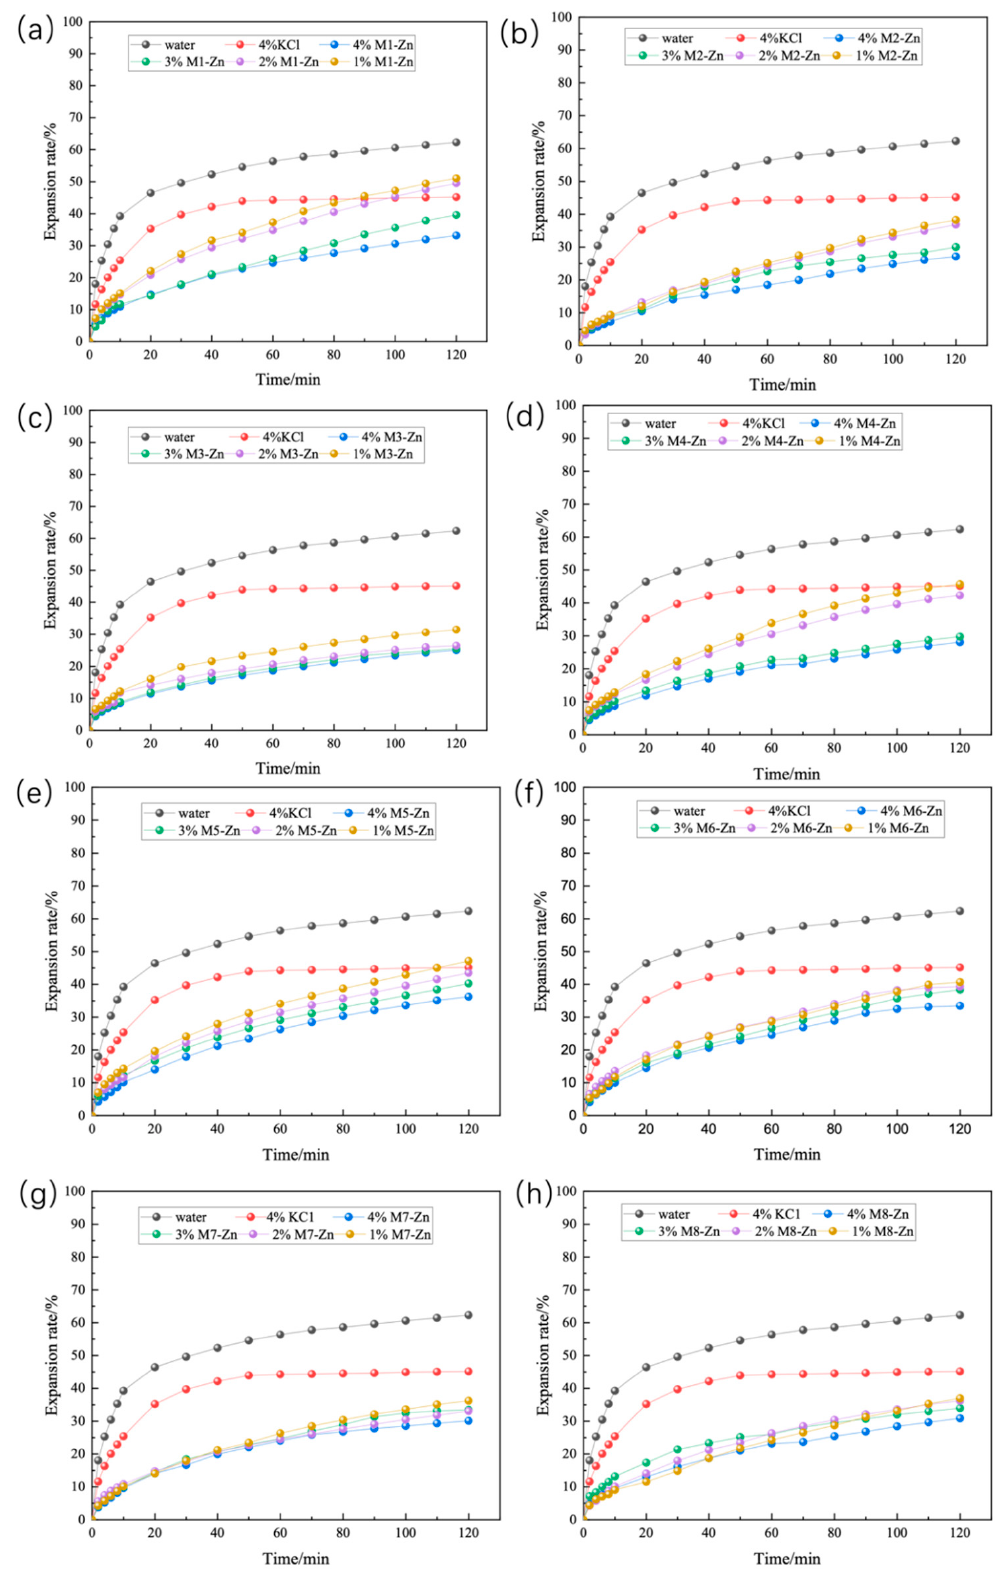
Figure 1. Linear expansion of Zn-doped MMH with different concentrations (( a ): M1-Zn; ( b ): M2-Zn; ( c ): M3-Zn; ( d ): M4-Zn; ( e ): M5-Zn; ( f ): M6-Zn; ( g ): M7-Zn; ( h ): M8-Zn).